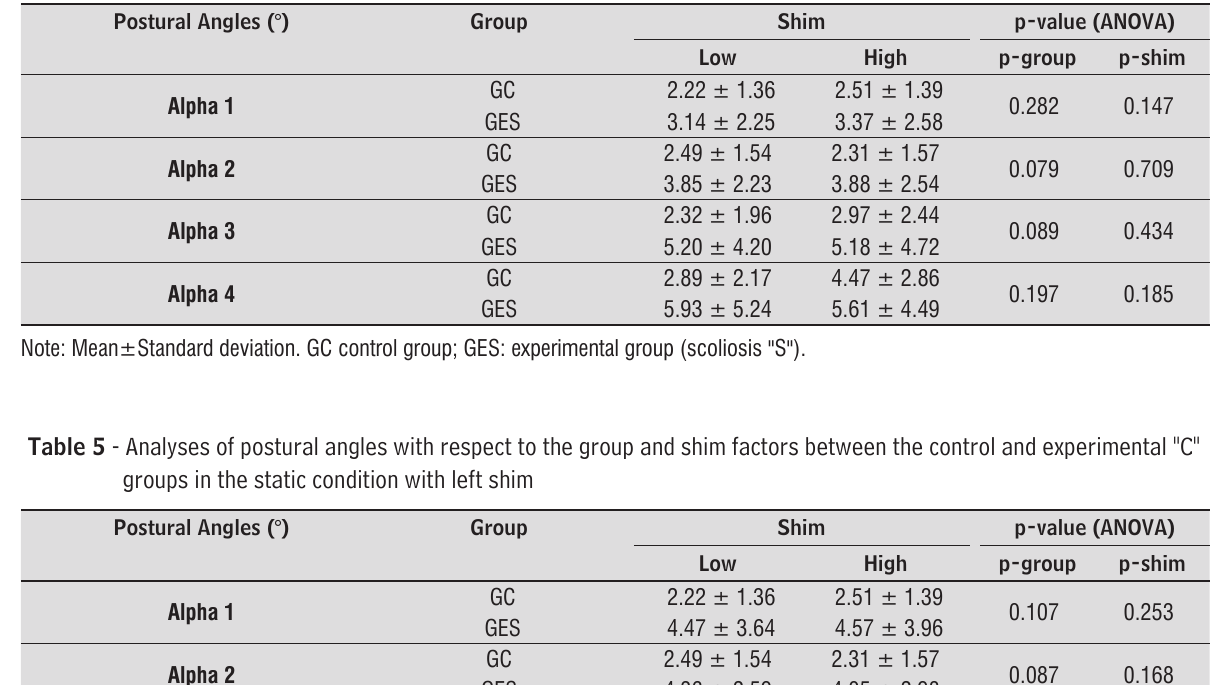
Table 4 - Analyses of postural angles with respect to the group and shim factors between the control and experimental "S" groups in the static condition with left shim